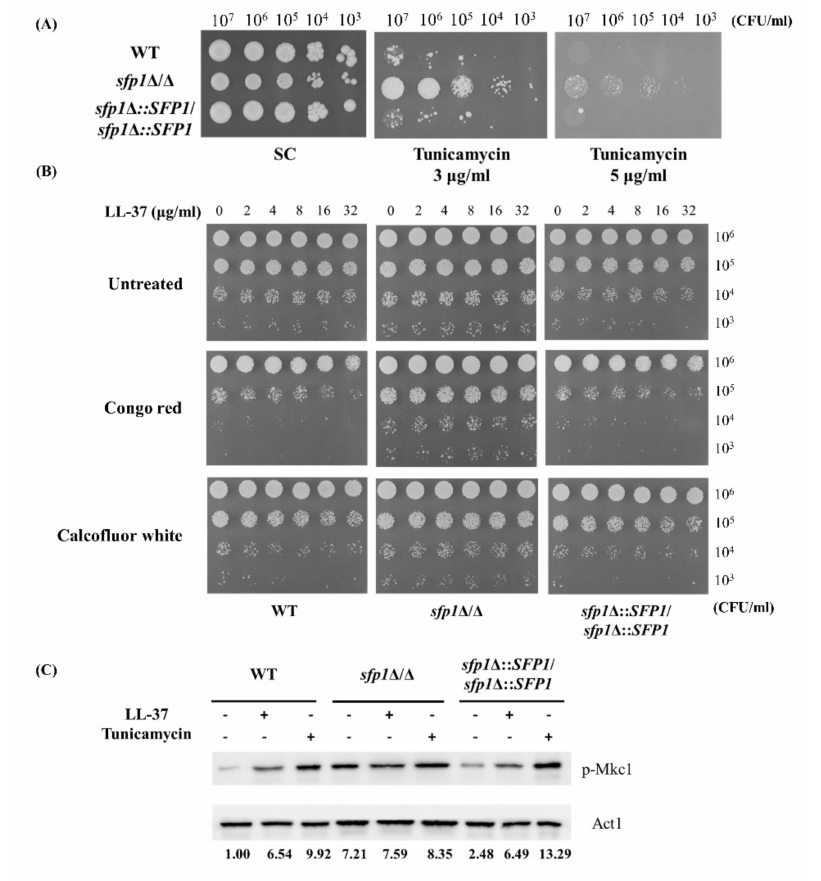
Figure 2. Assessment of the connection of Sfp1 with cell wall integrity and cellular response to LL-37. ( A ) Cells were serially diluted tenfold, spotted onto SC agar plates with or without tunicamycin (3 and 5 µ g/mL), and incubated at 30 ◦ C for 7 days. Representative data from at least three exper- iments with identified results are shown. WT: wild type; sfp1 ∆ / sfp1 ∆ : the SFP1 deletion mutant; sfp1 ∆ :: SFP1 / sfp1 ∆ :: SFP1 : the SFP1 -reintegrated strain. CFU: colony forming unit. ( B ) Cells were pretreated with different concentrations of LL-37 for 30 min, serially diluted tenfold and spotted onto SC agar plates with or without 30 µ g/mL congo red and 180 µ g/mL calcofluor white. The agar plates were incubated at 30 ◦ C for 5 days. Representative data from at least three experiments with identified results are shown. ( C ) Mkc1 activation induced by LL-37 in different C. albicans strains. Cells were treated with or without LL-37 (8 µ g/mL) or tunicamycin (5 µ g/mL) for 30 min. Equal amounts of protein extracts from each sample were loaded. p-Mkc1 was monitored by Western blotting and analyzed with ImageJ software. The Act1 band of each sample served as the loading control and was used to normalize the phosphor-Mkc1 levels indicated by the fold change values. The data are representative of three independent experiments with identical